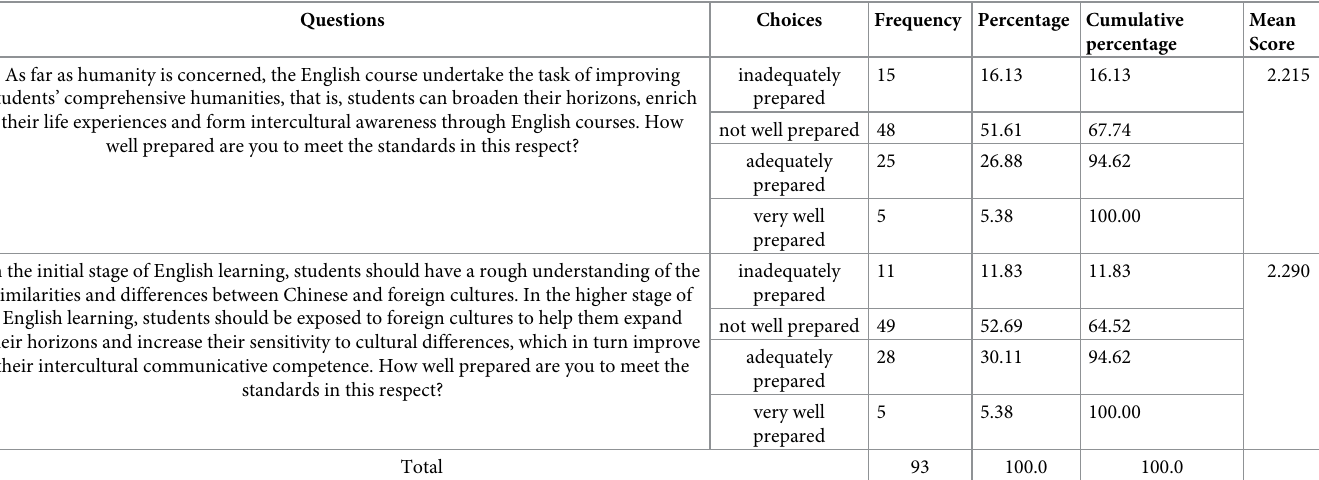
Table 4. Teacher preparedness in meeting the national standards -by frequency and by mean score.